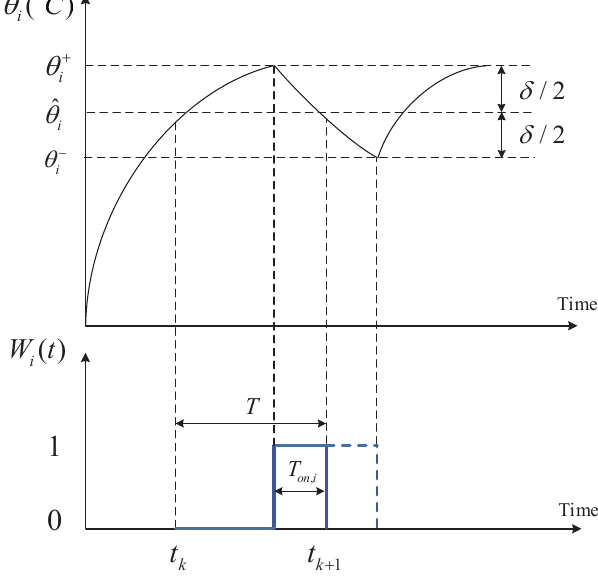
Figure 2. Temperature evolution procedure of thermostatically controlled loads